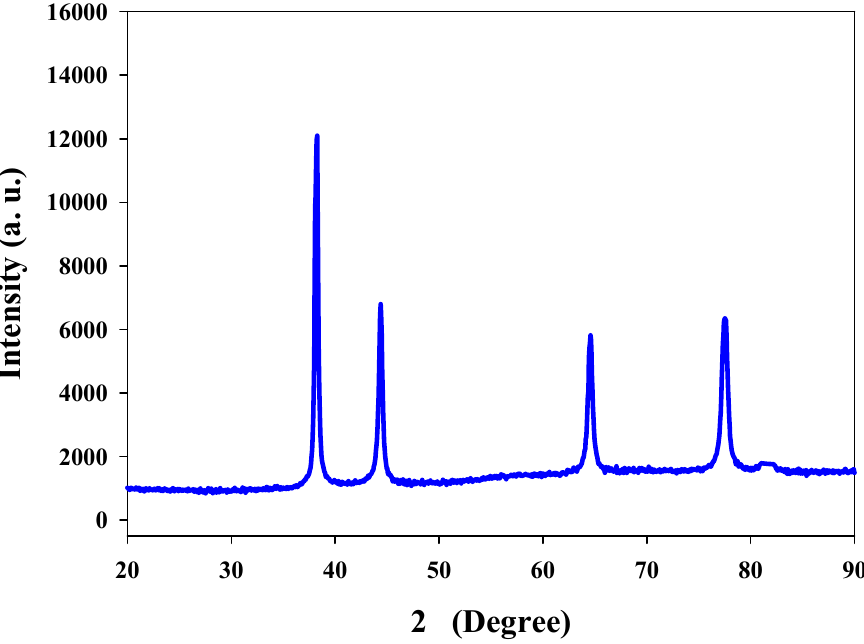
Figure 5. XRD pattern of Ta-AgNPs synthesized under optimized conditions.